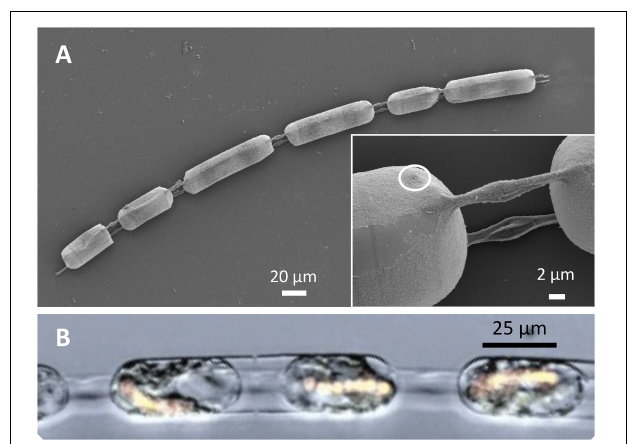
FIGURE 1 | Chains of Hemiaulus hauckii cells. (A) Scanning electron micrograph of a chain of cells that are joined by thin parallel extensions (elevations) of the frustule. Inset, magnified view of elevations; the circle highlights the possible external opening of the labiate process. (B) Overlay of light and epifluorescence micrographs (excitation filter at 490 nm; emission, 565 nm) of part of a chain of H. hauckii cells (water mount) illustrating that the longer frustules in panel A can contain two diatom cells each including endosymbiotic Richelia intracellularis (filaments of cells with yellow-orange